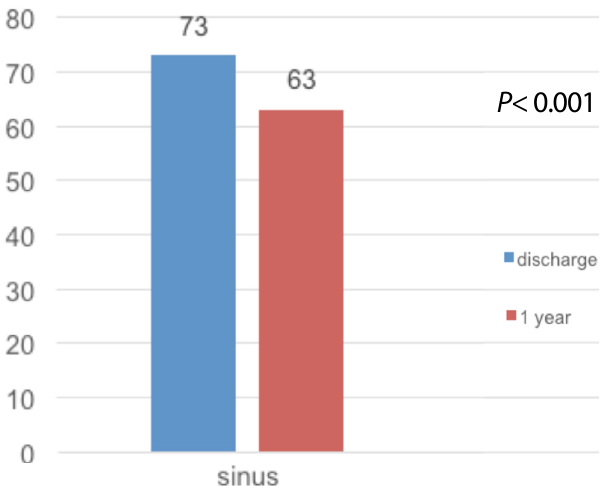
Fig. 6 - Cardiac rate at discharge and at the end of the 1-year postoperative follow-up period .